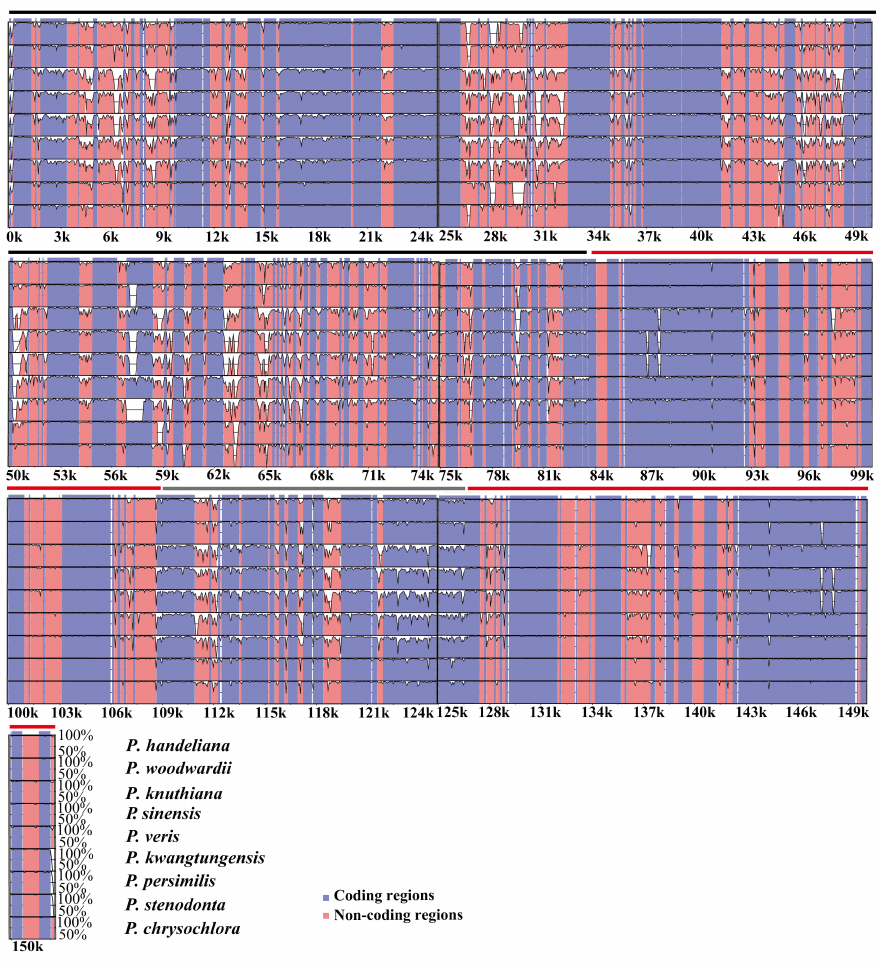
Figure 4. Sequence identity plot of the 10 Primula plastid genomes, with Primula poissonii as a reference. The y -axis represents % identity ranging from 50% to 100%. Coding and non-coding regions are marked in purple and pink, respectively. The red, black, and gray lines show the IRs, LSC, and SSC regions,